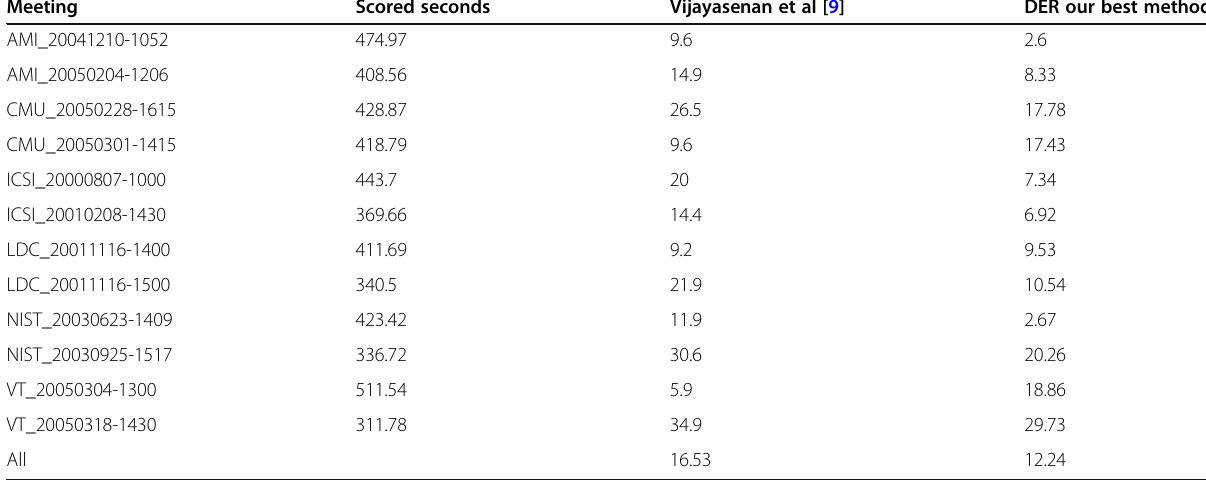
Table 17 DER for a single channel compared with the information bottleneck approach [9] for the devel06 set